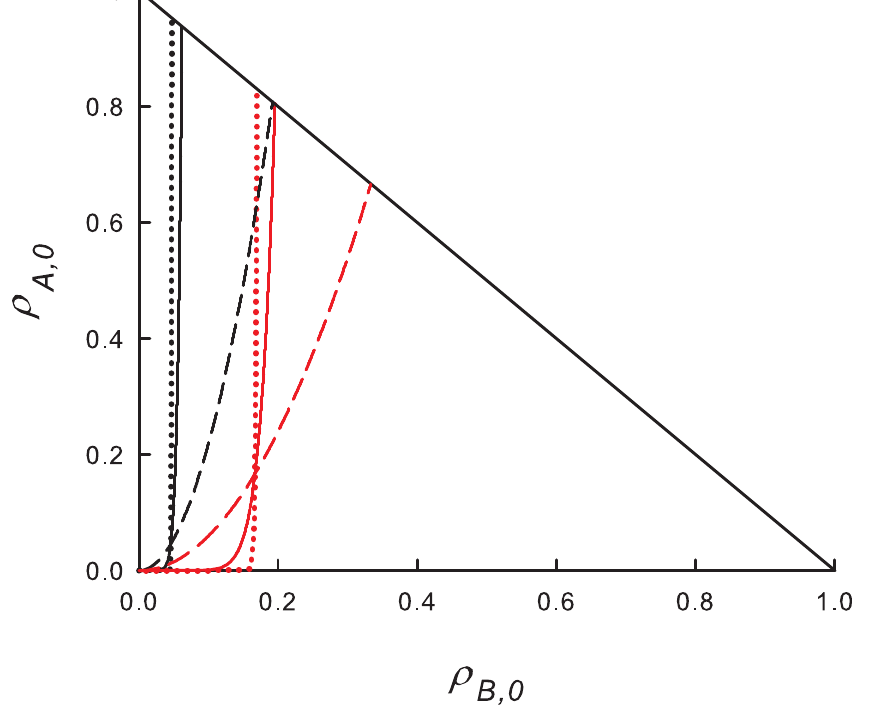
Fig 1. (Color online) MF equations: Boundaries between initial populations that lead to a stationary solution with ρ A > ρ B (to the left of the boundary) or vice-versa. Black curves: λ = 1.1, red curves: λ = 1.5. Dotted lines: α = 0.01; solid lines: α = 0.1; dashedlines: α = 0.5.